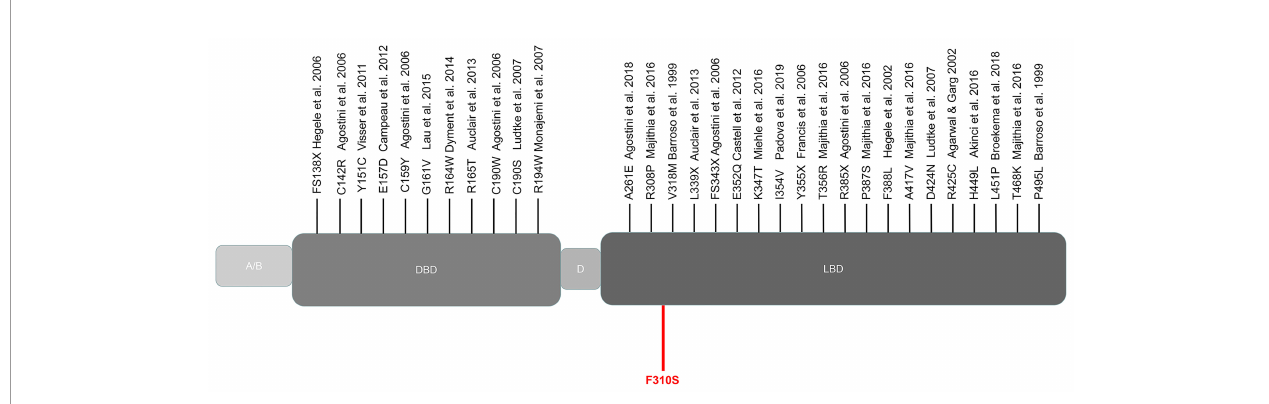
FIGURE 4 | Schematic representation of the PPAR g domain structure and position of the mutations reported thus far from patients with FPLD3. Marked in red: novel mutation c.929T > C described in our study. A/B, N-terminal region; DBD, DNA-binding domain; D, hinge domain; LBD,